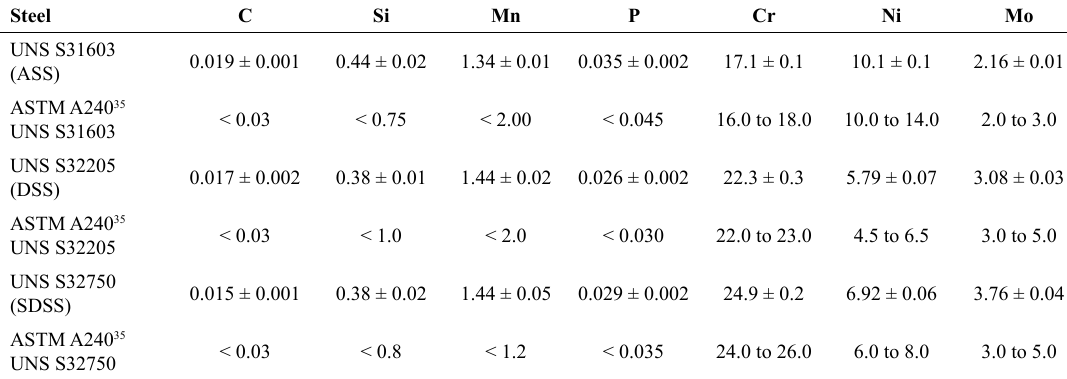
Figure 5. Microstructure of the investigated SSs: (a) UNS S31603 ASS; (b) UNS S32205 DSS; (c) UNS S32750 SDSS. Optical microscope. Electrolytic etching: oxalic acid for ASS and KOH for DSS and ASS. Table 2. Chemical composition of UNS S31603 ASS, UNS S32205 DSS and UNS S32750 DSS